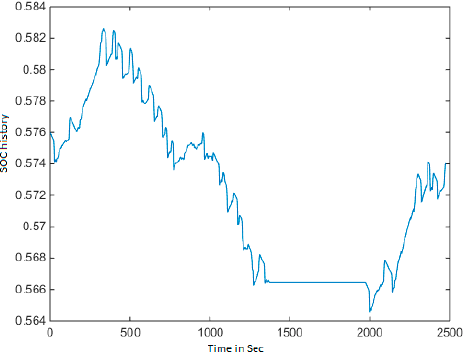
Figure 9. SOC history. Energies 2020 , 13 , x FOR PEER REVIEW